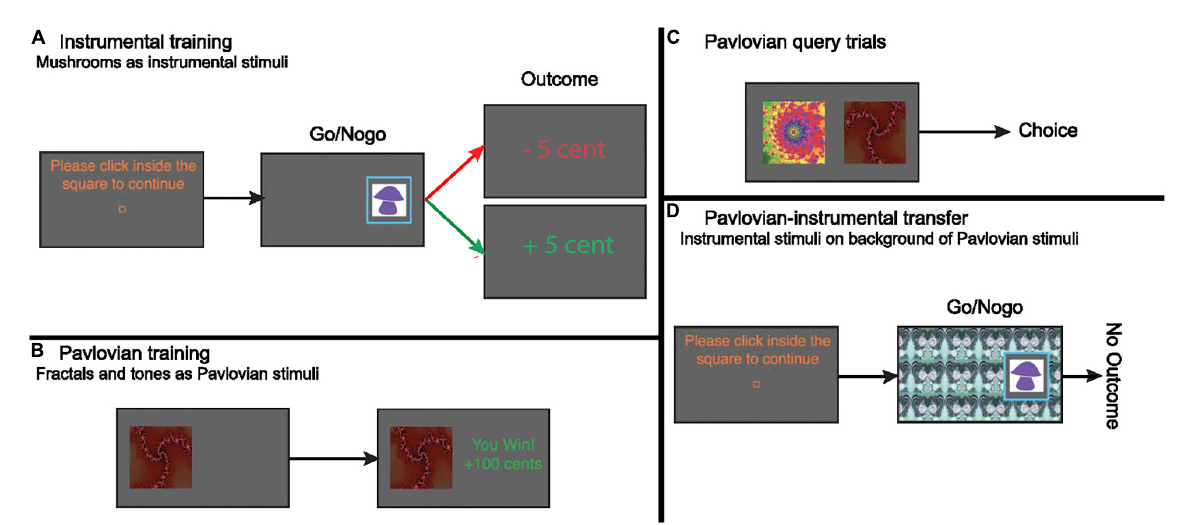
FIGURE1 (A) Instrumental conditioning. To center the cursor, participants clicked in a central square. Participants needed to choose whether to move the cursor toward the mushroom and click inside the blue frame onto the mushroom (go), or do nothing (NoGo). Outcomes were presented immediately after go actions, or after 1.5 s (i.e., NoGo). There were 3 “good” (go) and 3 “bad” (NoGo) instrumental stimuli. Collecting a “good” (correct go) and not collecting a “bad” (correct NoGo) stimulus was rewarded most of the time (75% veridical outcome). Vice versa, collecting a “bad” (incorrect go) and not collecting a “good” (incorrect NoGo) stimulus was punished most of the time (75% veridical outcome). There were 60 trials in total. Instrumental stimuli were different for both days. (B) Pavlovian conditioning. Participants passively viewed stimuli and heard auditory tones, followed by wins (+10/+100), losses (–10/–100), or neutral outcomes (0). There were five fractal/tone combinations. Each combination was displayed 12 times. (C) On Pavlovian query trials, participants chose between two Pavlovian stimuli. Query trials were administered after every five Pavlovian conditioning trials. (D) Pavlovian-instrumental transfer. Participants responded to the instrumental stimuli trained during the instrumental conditioning stage, with Pavlovian stimuli tiling the background. No outcomes were presented, but participants were instructed that their choices counted toward the final total. No explicit instructions about the contribution of Pavlovian stimuli toward the final total were given. During this phase we assessed the impact of the Pavlovian CSs on instrumental choice